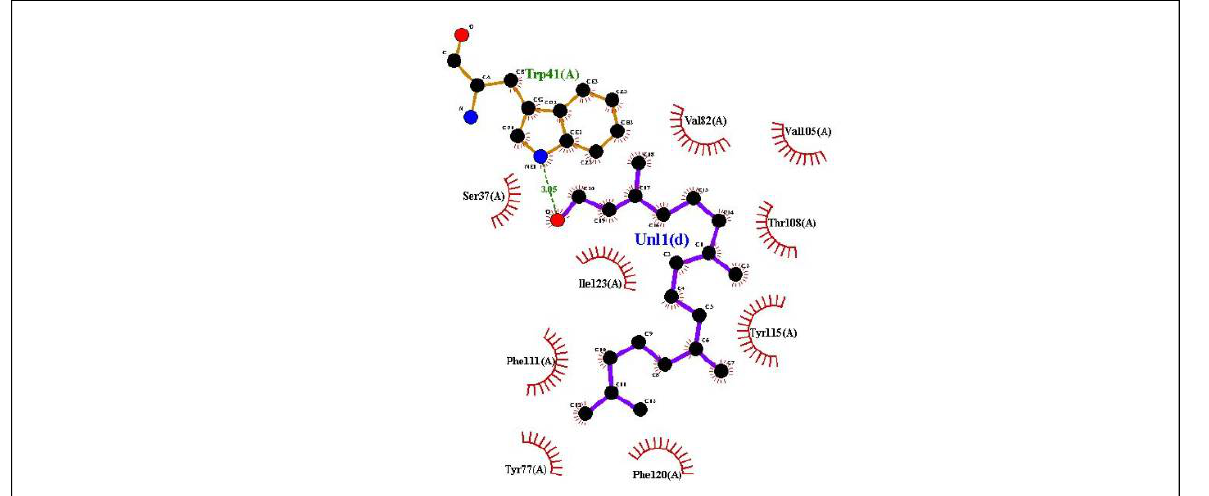
Note: Phytol (ligand) form one hydrogen bond (represented as green broken lines with bond length) with amino acid Try41 of plasmepsin II